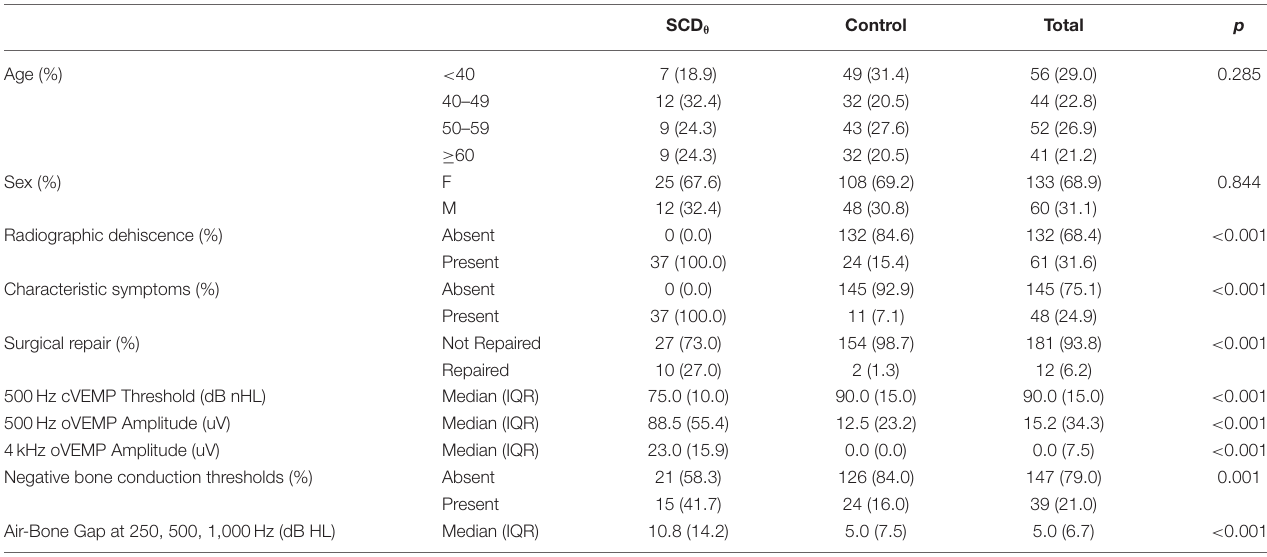
TABLE 1 | Patient characteristics for patients with superior semicircular canal